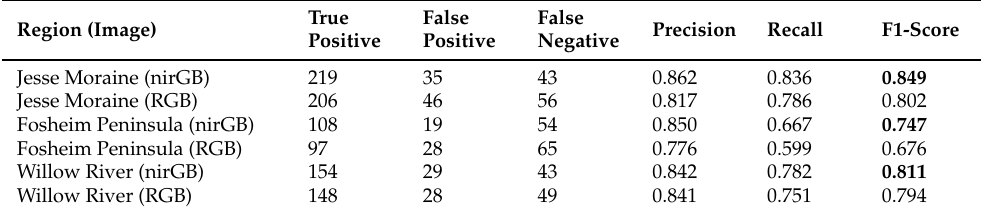
Table 2. The accuracy of mapped polygons for three study areas (RGB and nirGB). The highest F1 score in each study region is shown in